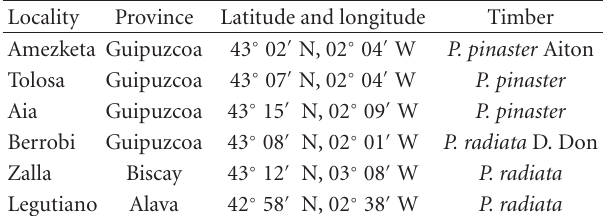
Table 1: Sampling sawmills located at the Basque Country (north- ern Spain). Pinus L. species (Pinales: Pinaceae) is also indicated within each